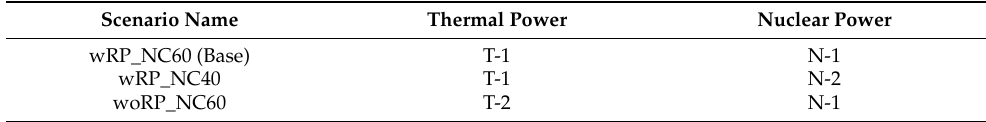
Table 5. Strategies of Company